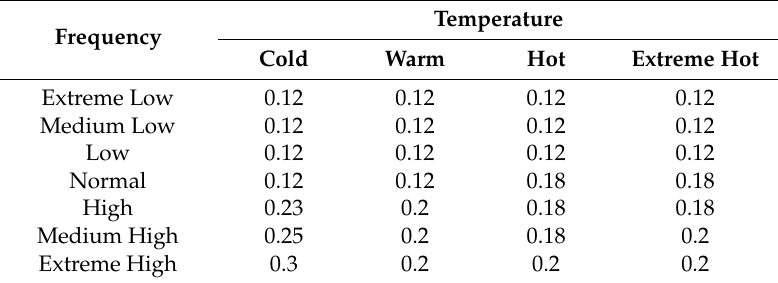
Table 3. Fuzzy rules for P gain ( k p ).